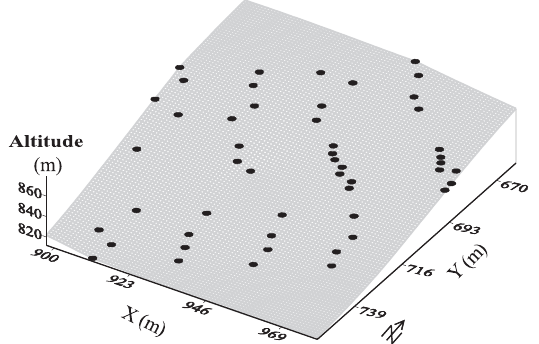
Figura 1. Modelo digital de elevação (MDE) da área em estudo, com a distribuição dos pontos